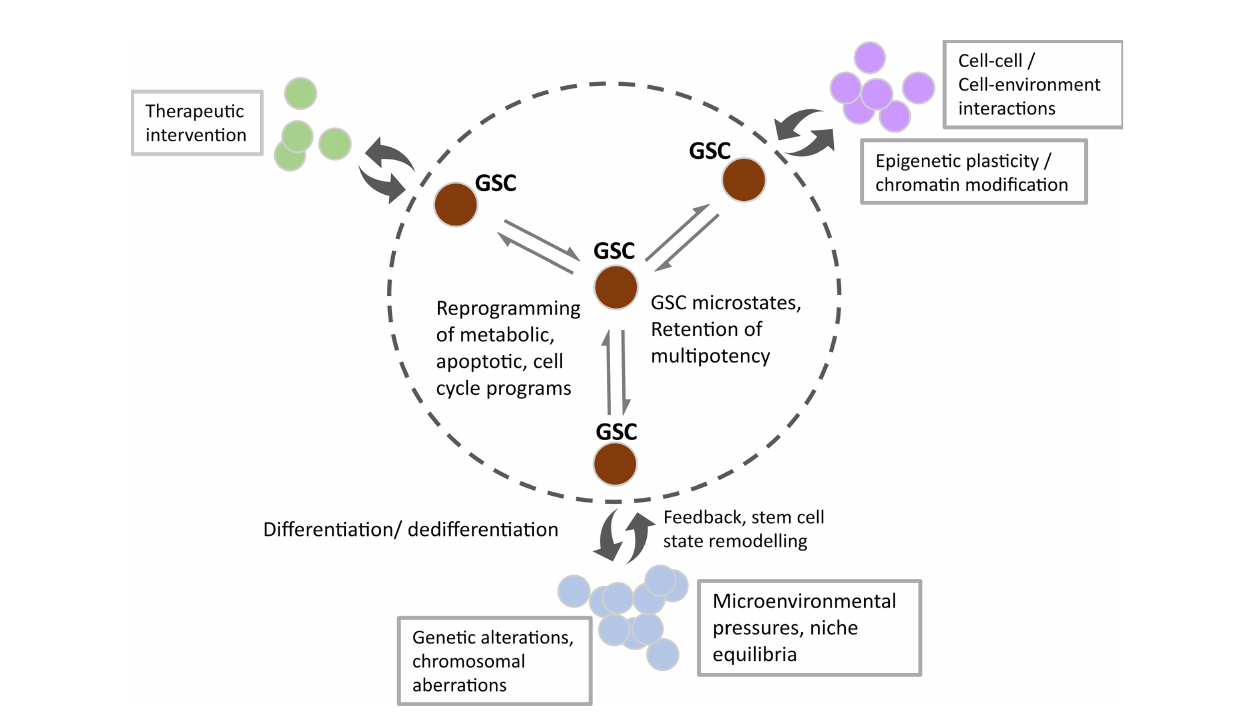
FIGURE 2 | Schematic showing the microstate transitions within the GSC population (within the circled dotted line) due to enhanced transcriptional and epigenetic potential, underpinned by extrinsic cues. Double headed arrows represent dynamic transitioning between GSC states, resulting in cellular reprogramming of metabolic, apoptotic and cell cycle programs. Non-tumorigenic subpopulations emerge due to the reversible differentiation and feedback of GSC states (double-headed curly arrows). Factors affecting transition state, subpopulation size and dynamic fl uxing between states include external cues such as therapeutic intervention, cell-cell/cell- environmental interactions and spatial tissue characteristics. Intrinsic changes manifest as subpopulations with distinct genetic/chromosomal aberrations and epigenetic